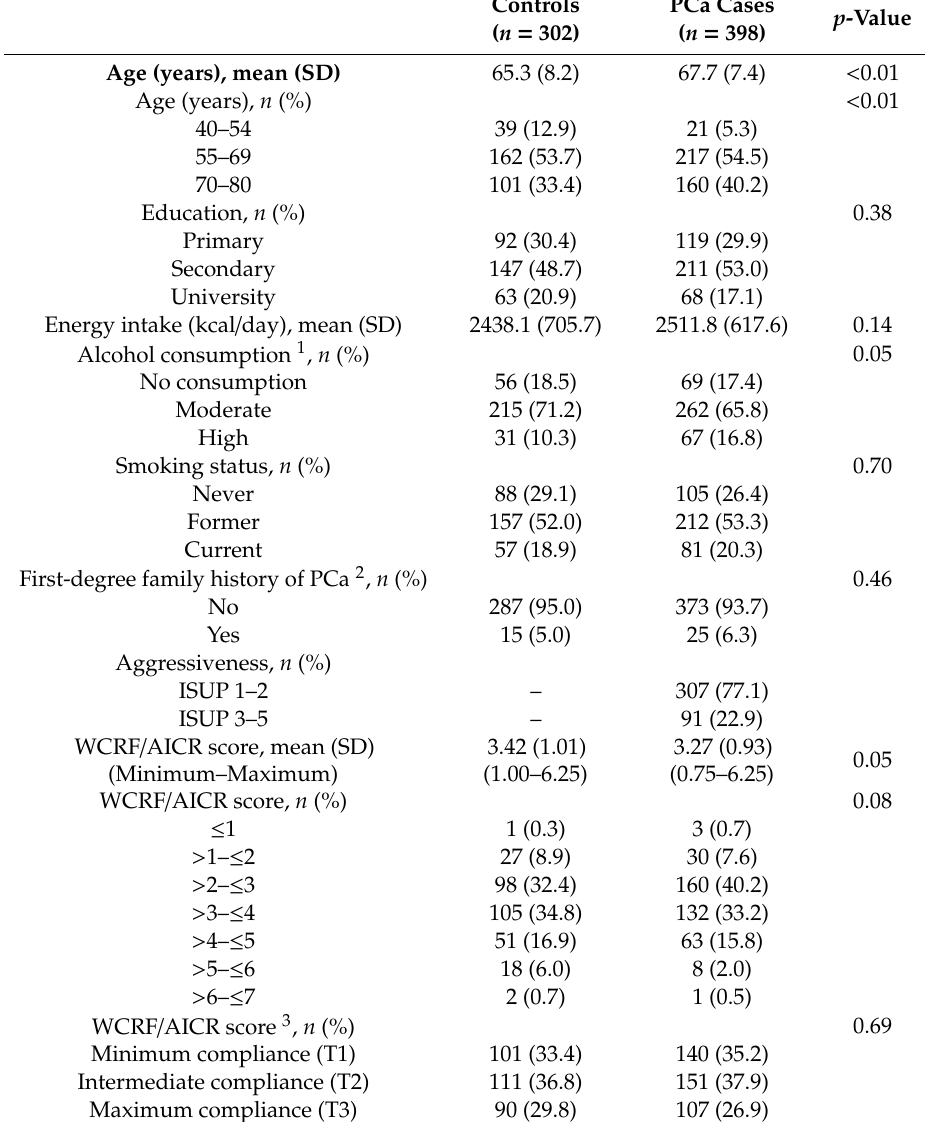
Table 2. Characteristics of controls and prostate cancer (PCa) cases in CAPLIFE